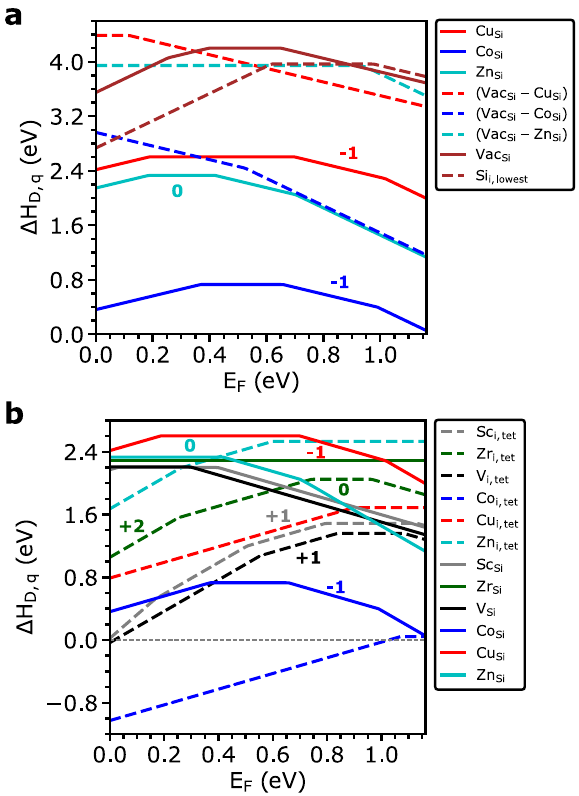
Fig. 6 Defect formation energy for candidate defects and their potential competing defects. Comparison between ( a ) candidate substitutional defects and the vacancy complex counterparts and ( b ) candidate substitutional and interstitial defects are shown. The number indicates the dominant charge state at a given Fermi energy range and highlights the charge states of the candidate substitutional and interstitial defects. Note that the intermediate compounds are not considered here, i.e., total energies of the reference element states are used for the chemical potentials. Vac is used for Si vacancy to be distinct from Vanadium (V). For Si interstitials, only the one with the lowest energy among three defect types (tetrahedral, hexagonal, and split) at a given Fermi energy is shown.